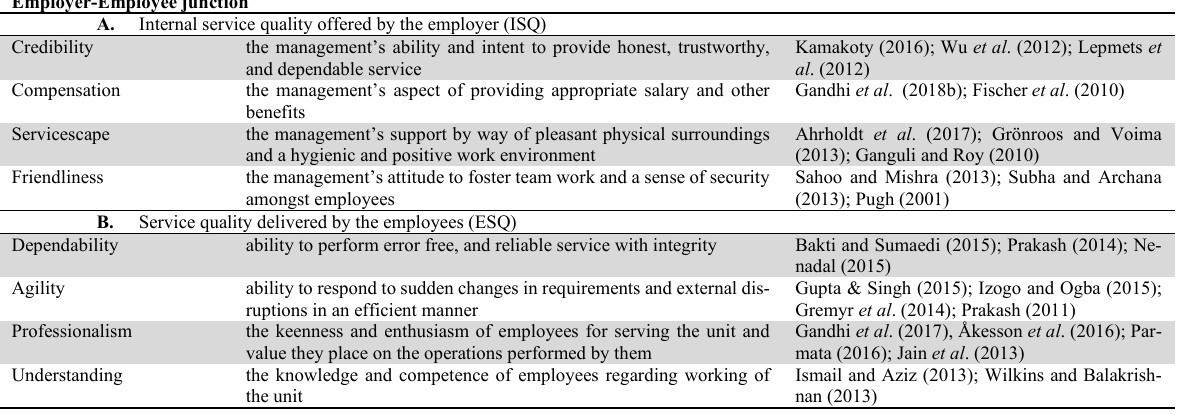
Independent variables and their operational